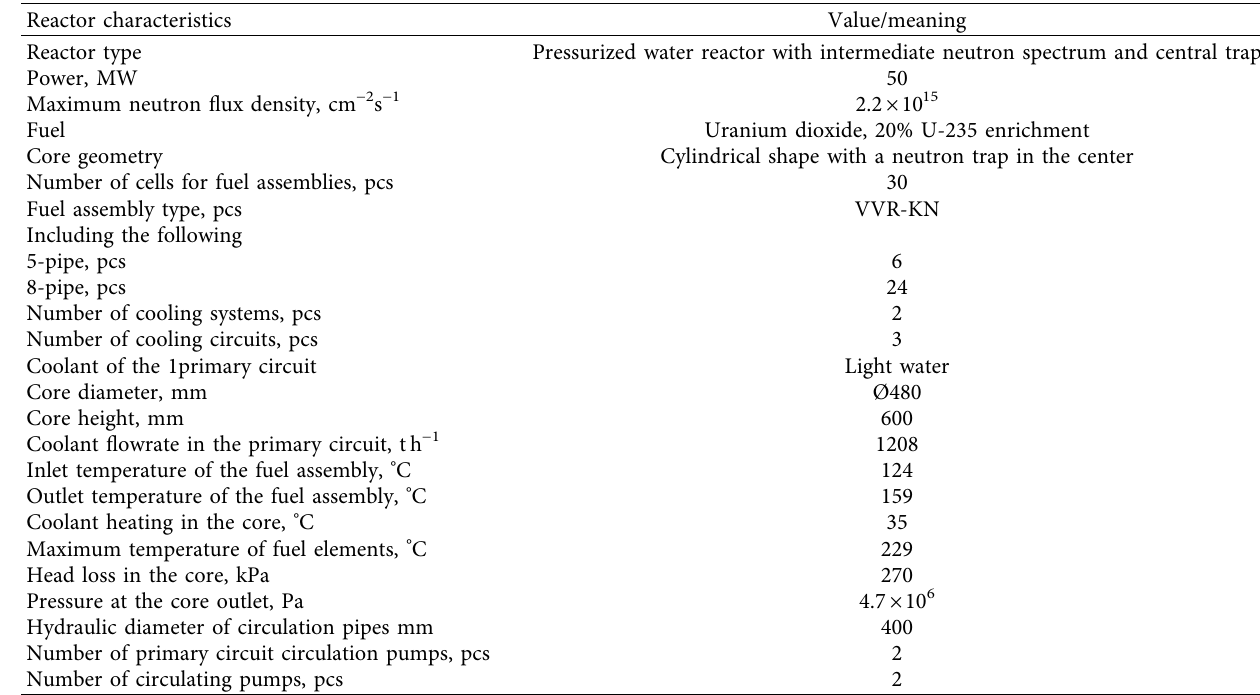
Figure 1: Sketches of a three-dimensional model of the heat removal system of a 50MW hybrid nuclear facility with a beryllium reflector located in the pool: (1) reactor vessel; (2) neutron reflector; (3) outlet (hot) pipeline; (4) supply (cold) pipeline; (5) volume compensator; (6) steam generator; (7) steam pipe; (8) air heat exchanger; (9) condensate return; (10) air heat exchanger housing; (11) chimney; (12) valves of the shortened natural circulation circuit; (13) reactor pool; (14) pipelines of the pool cooling circuit; (15) natural circulation valve through the reflector. Table 1: Main parameters of a high-flux